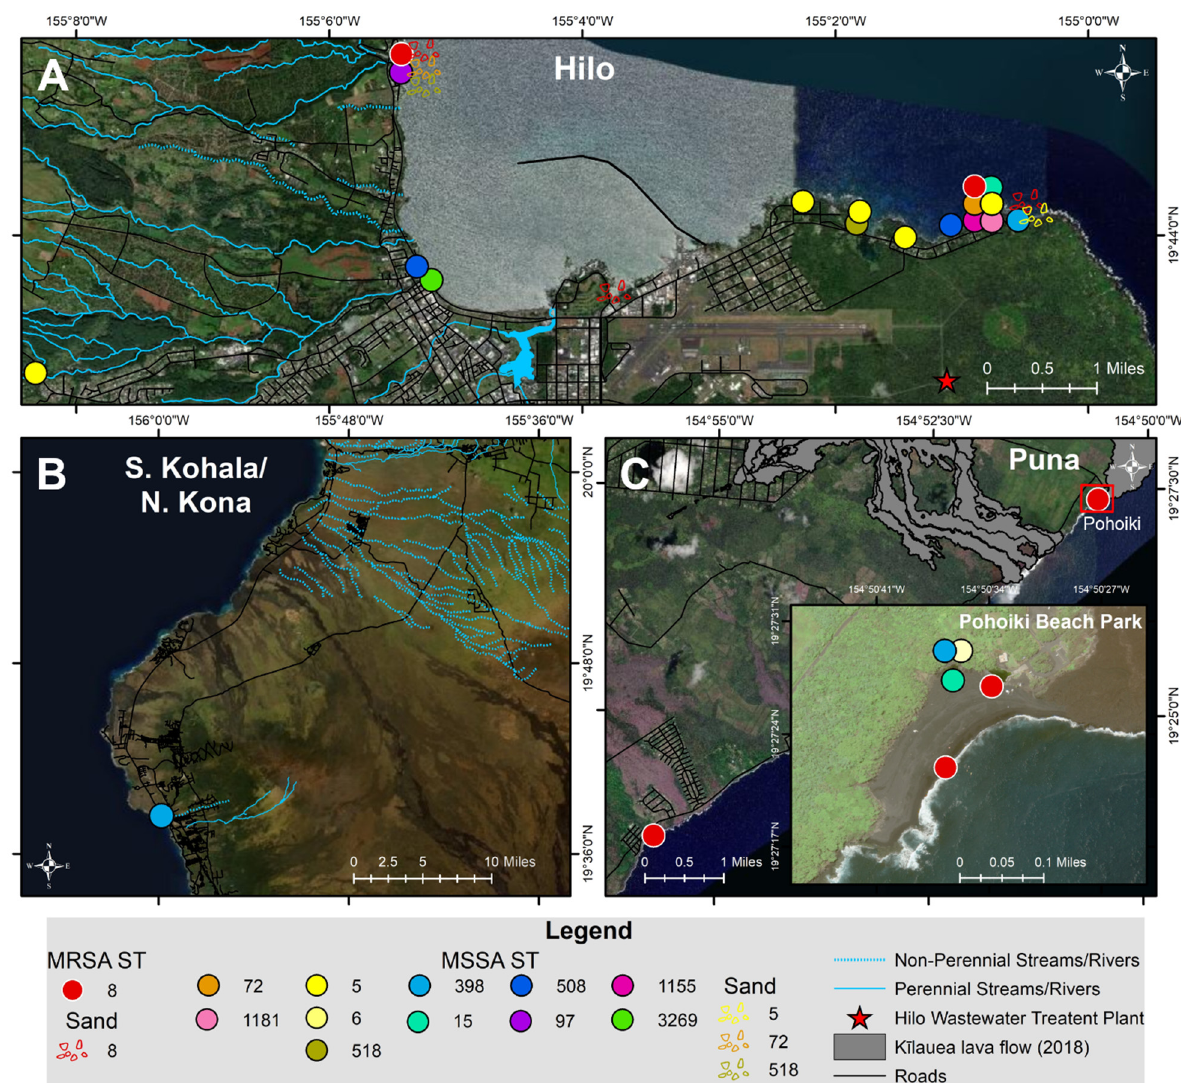
Figure 2. Map of MRSA and MSSA sequence types (ST) isolated from coastal beach and river waters, anchialine pools, and sand from July–December 2020 in the districts of ( A ) Hilo, ( B ) S. Kohala, N. Kona, and ( C ) Puna on Hawai ʻ i Island, Hawai ʻ i.